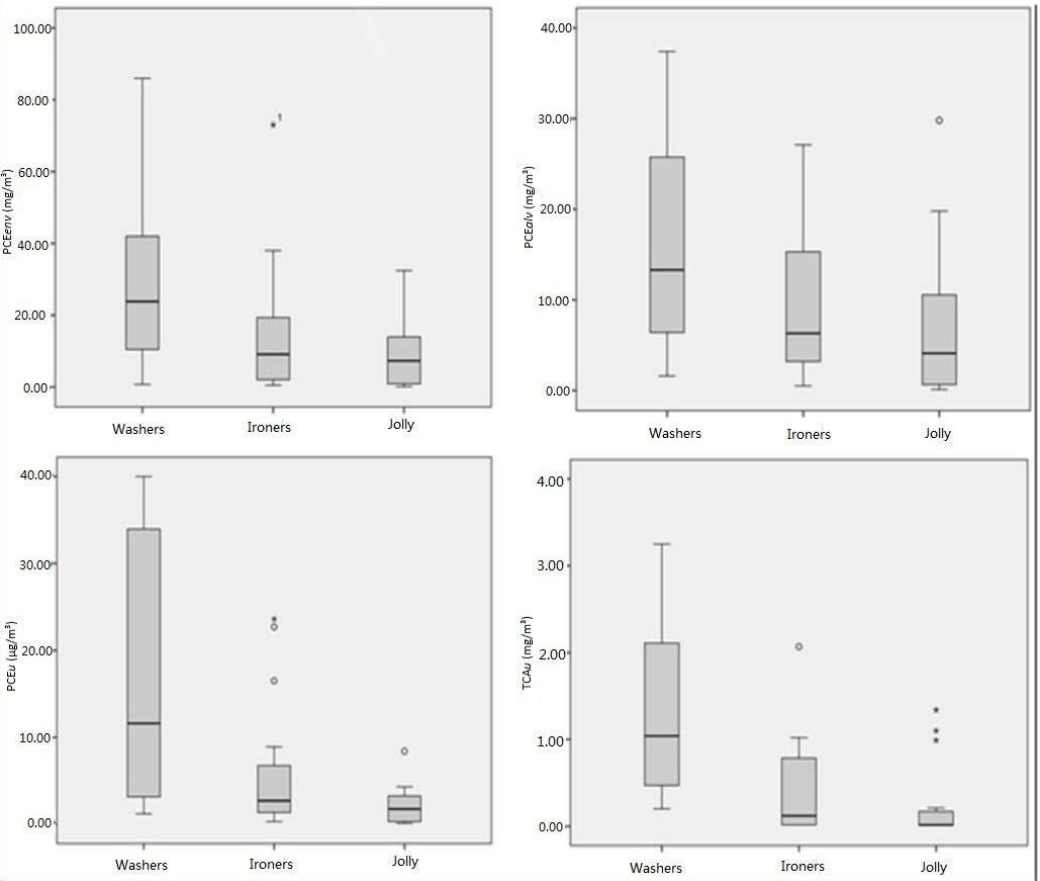
Figure 1. Graphical representation of the occupational perchloroethylene (PCE) exposure indices among the subjects classified according their working tasks (PCE env : PCE environmental concentrations, PCE alv : PCE in exhaled alveolar air, and PCE and trichloroacetic acid (TCA) in urine samples collected at the end of the work shift (PCE u and TCA u respectively). 1 Asterisks and dots in the figure represent outliers.